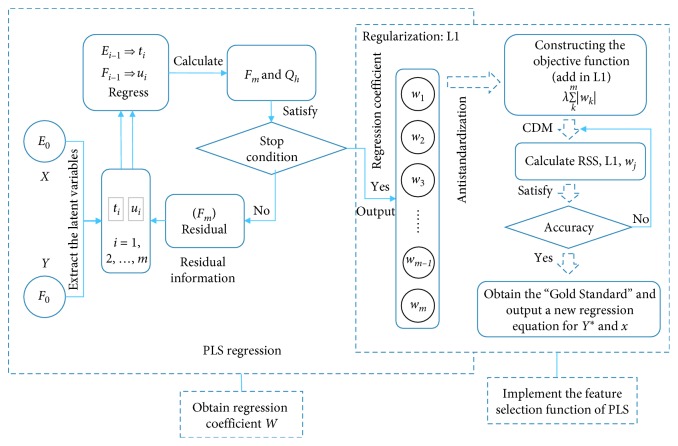
LAPLS structure.